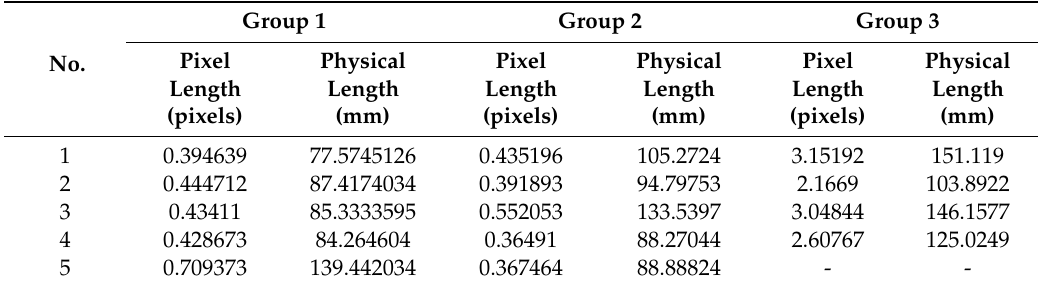
Table 9. Pixel length and physical length between the mark points in reconstruction using A-SfM.